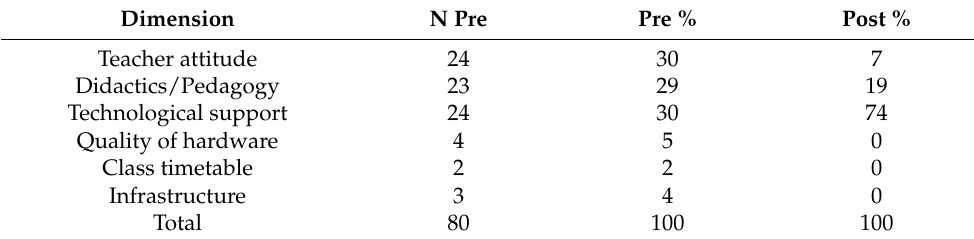
Figure 1. Barriers to improving music education. Table 2. Barriers to improving music